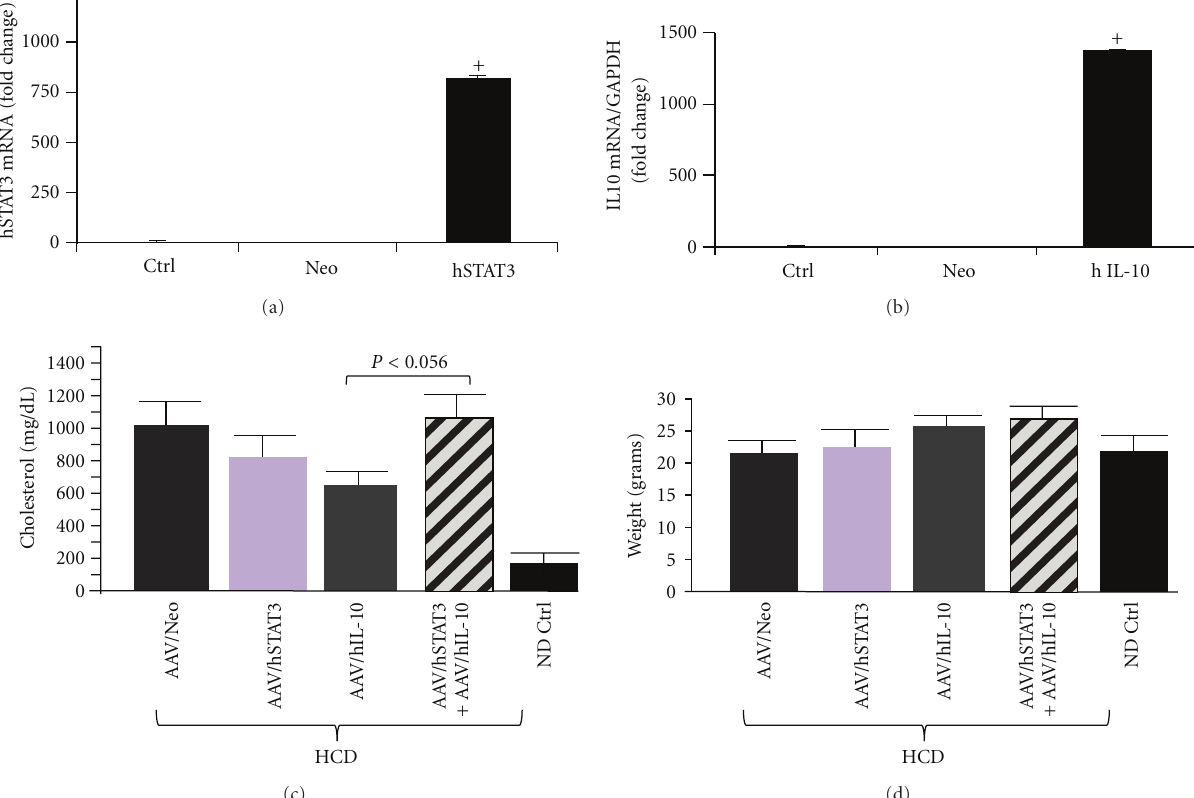
Figure 3: Expression of the delivered hSTAT3 and IL-10. Relative expression of hSTAT3 (a) and IL-10 (b) genes by real-time quantitative PCR from aorta of 3 mice in each group. For qRT-PCR the quantity of RNA for each gene was normalized to GAPDH in the same sample. Data shown are mean ± SE. (c) shows the levels of total cholesterol. Note that cholesterol levels of the hSTAT3-plus-hIL-10-treated animals had significantly higher cholesterol levels than animals treated with individual genes. (d) shows the animal weights at the end of the experiment. The key at the bottom is used for both panels (c) and